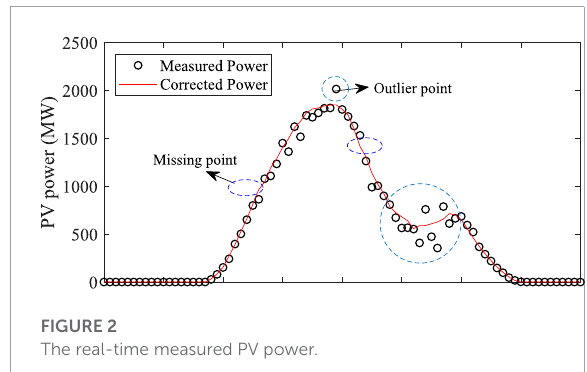
FIGURE 2 The real-time measured PV power.